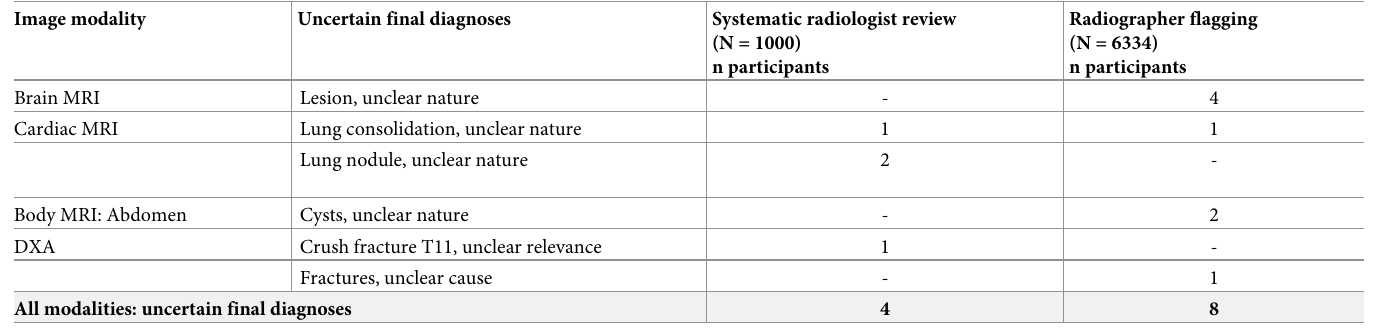
Table 5. Uncertain final